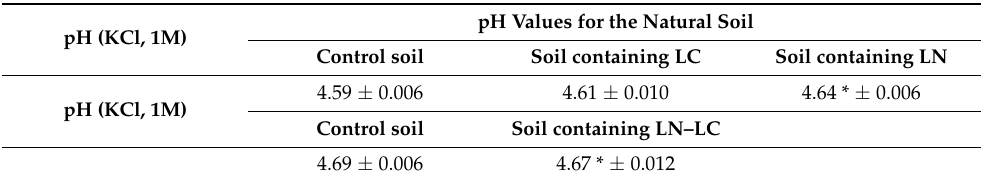
Table 2. Average pH values determined for the natural soil containing the different formulations of lambda-cyhalothrin (LC) at the concentration of 28 g LC ha − 1 after 15 days of incubation. Results are represented by mean values ± standard deviation (SD) (n =